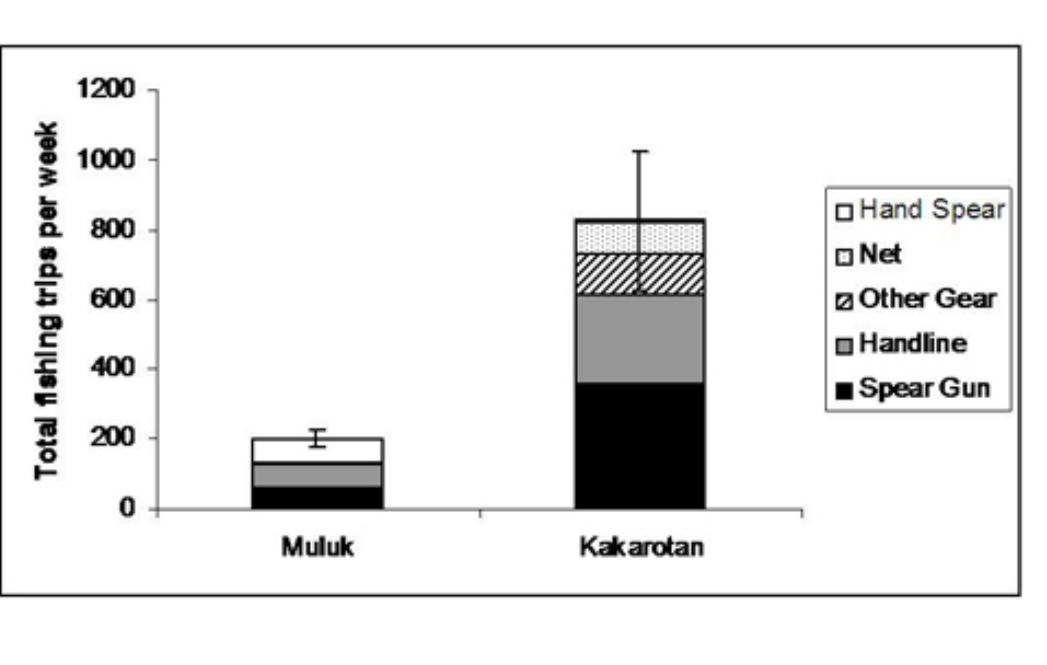
Fig. 3. Fishing trips/wk by gear type for Muluk and